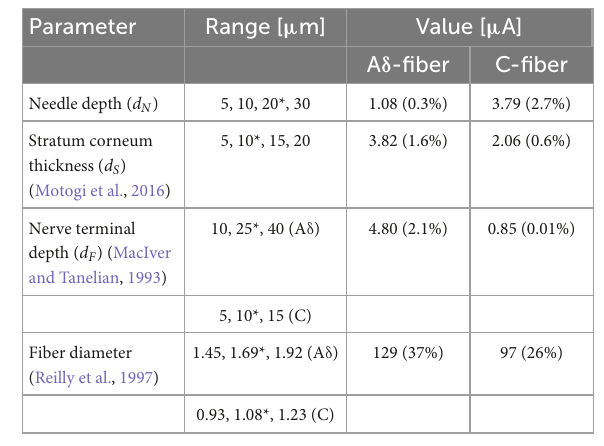
TABLE 4 Maximum variation in the computed injection current thresholds for the reported range values of the simulation